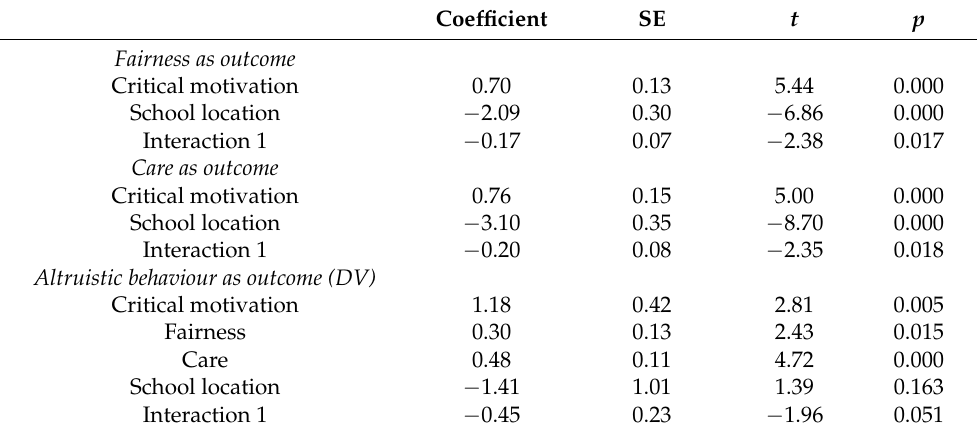
Table 3. Results for the Regression Models used for Testing the Double Moderated Mediation.